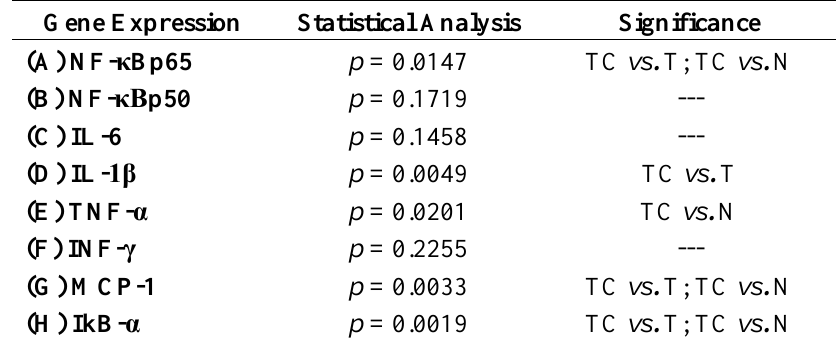
Table 2. General characteristics of patients in each group.